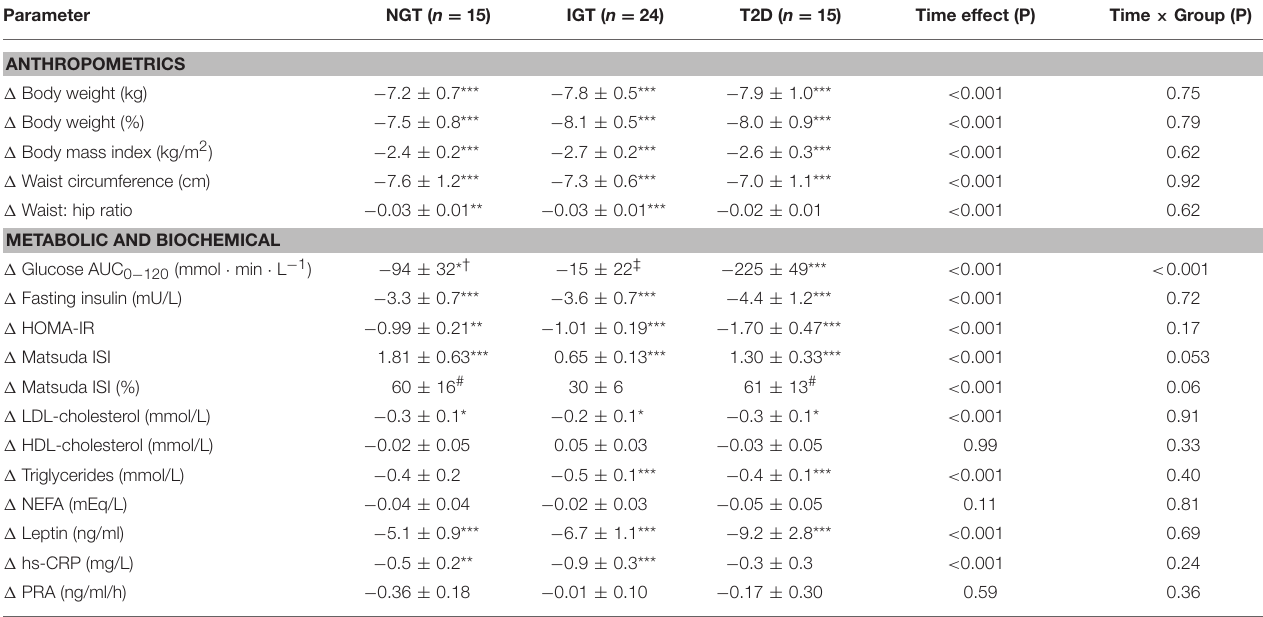
TABLE 2 | Changes in selected anthropometric and clinical data after hypocaloric diet. Parameter NGT ( n = 15) IGT ( n = 24) T2D ( n = 15) Time effect (P) Time × Group (P)